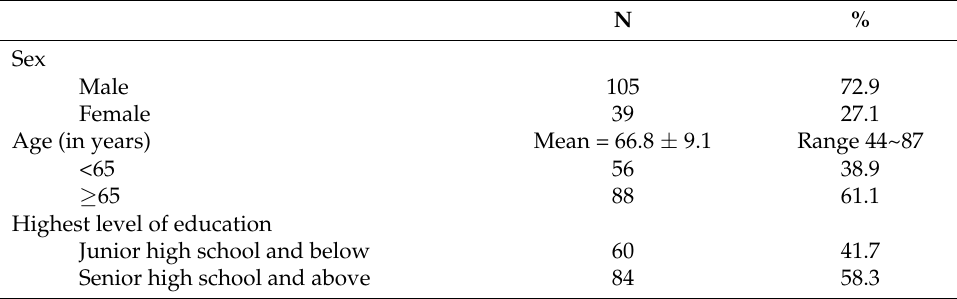
Table 1. Demographic and disease data of CKD patients (N =